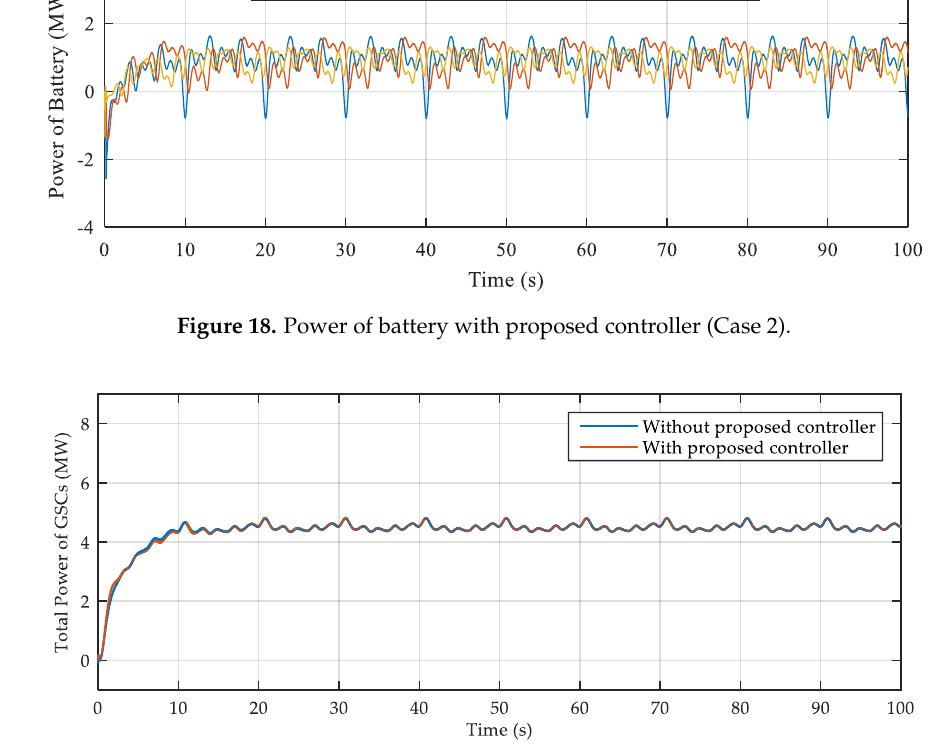
Figure 19. Total active power of GSCs in case of different initial SOCs.